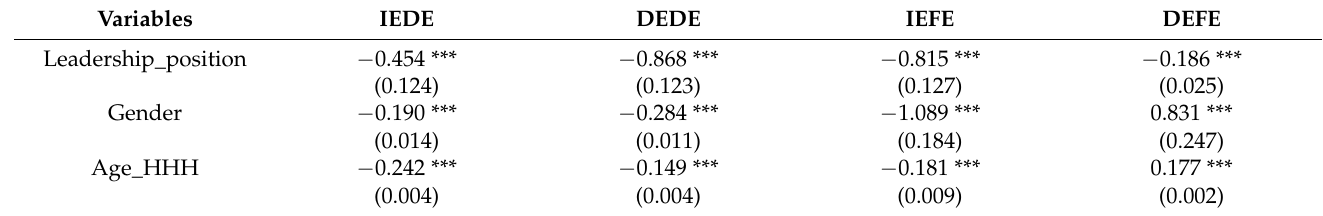
Table A2. First-stage estimations of determinants of direct and indirect exposure to land grabbing by domestic and foreign